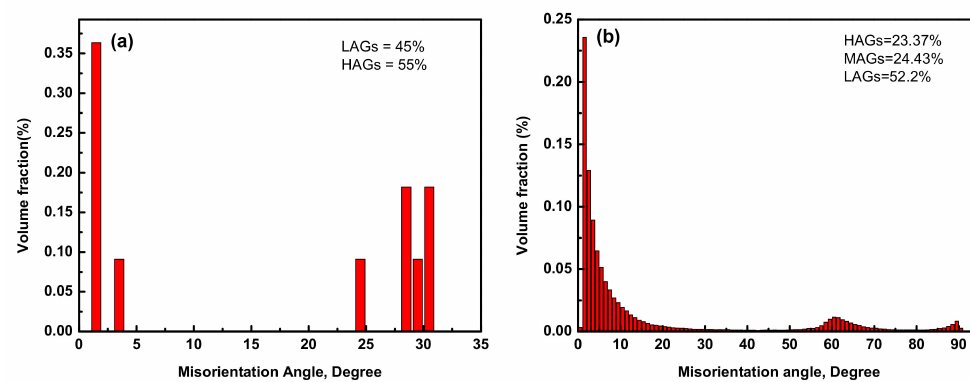
Figure 14. α phase misorientation angle distribution chart for deformations at different strain rates,